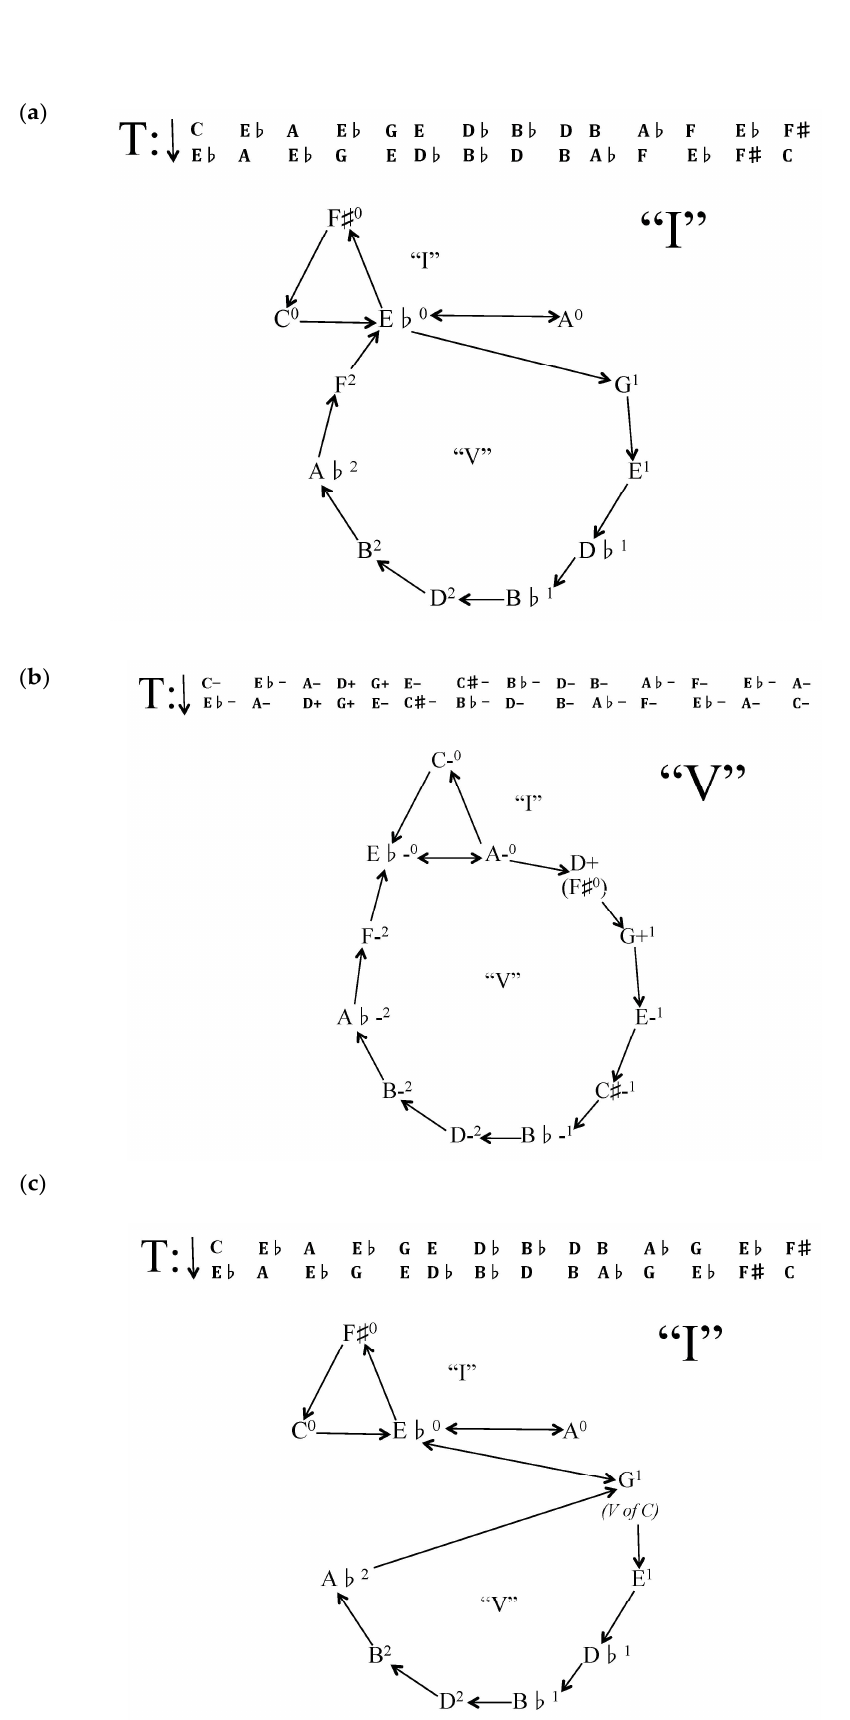
Figure 7. Kinematic analysis of the first 19 measures of Many Many Cadences. ( a ) Measures ( a ) Measures 1–6; ( b ) Measures 7–13; ( c ) Measures 1–6; ( b ) Measures 7–13; ( c ) Measures 14–9.